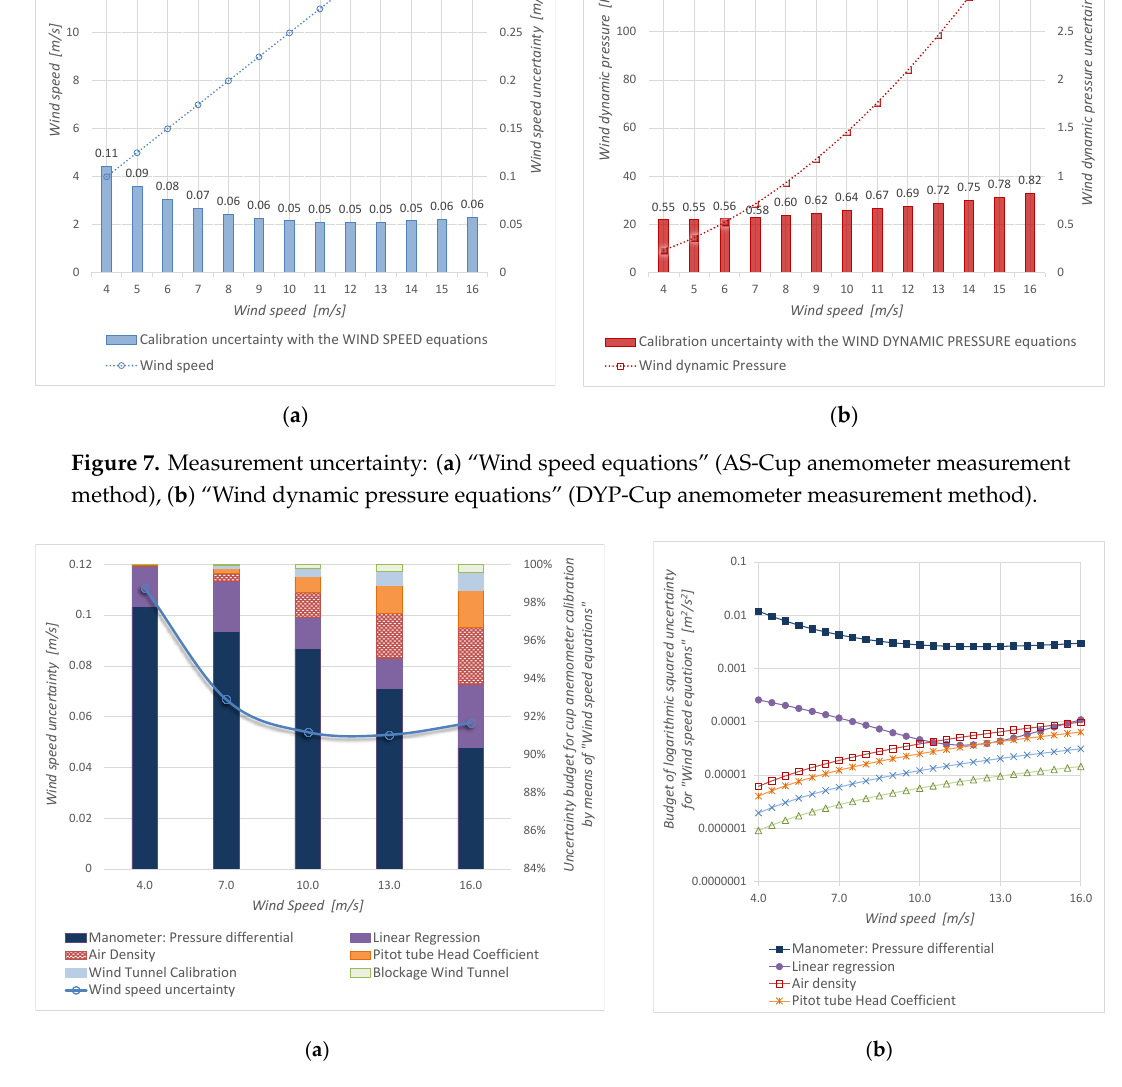
Figure 8. Calibration by means of “Wind speed equations” (AS-Cup anemometer measurement procedure): ( a ) wind speed uncertainty and its budget, ( b ) components of the squared uncertainty.